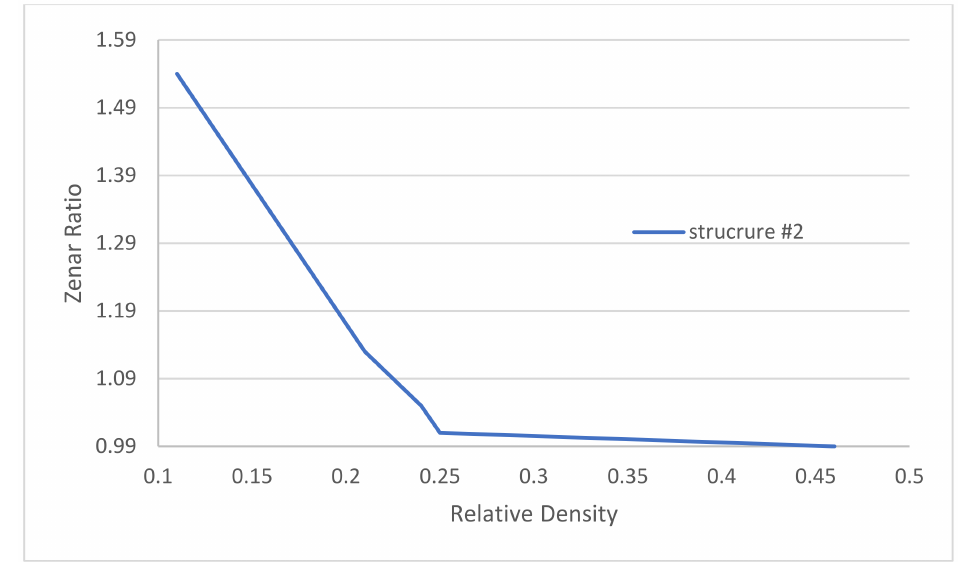
Figure 15. Zener ratio values of different relative densities structure